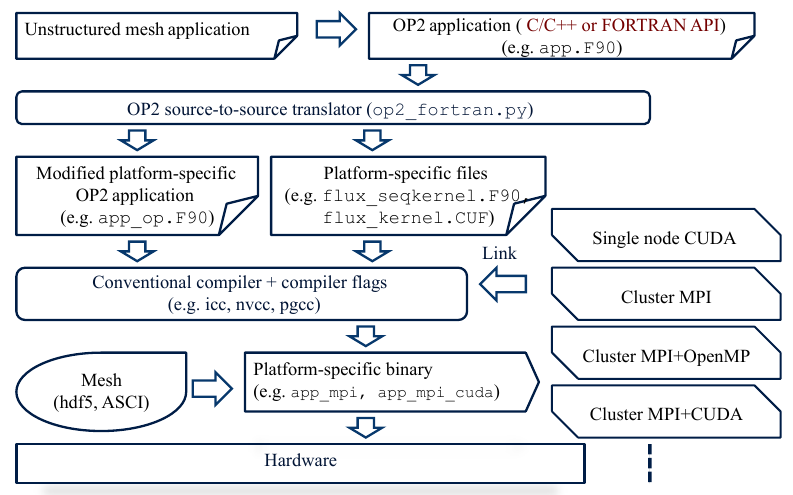
Figure 1. Building system with OP2.